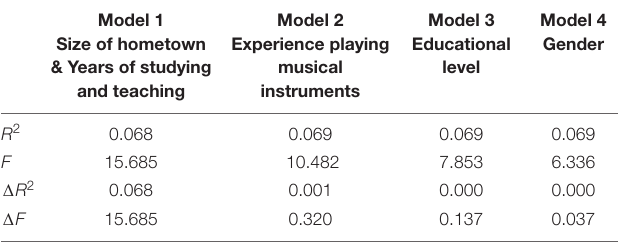
TABLE 4 | Hierarchical regression predicting MPQ-SF:model summary.